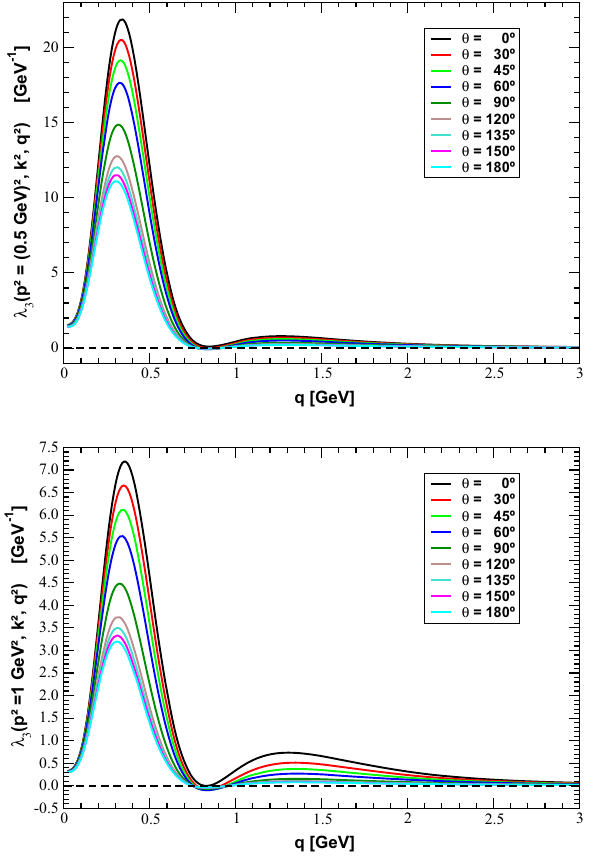
Fig. 41 λ 4 for p = 0 . 5 GeV (top) and p = 1 GeV (bottom) and various